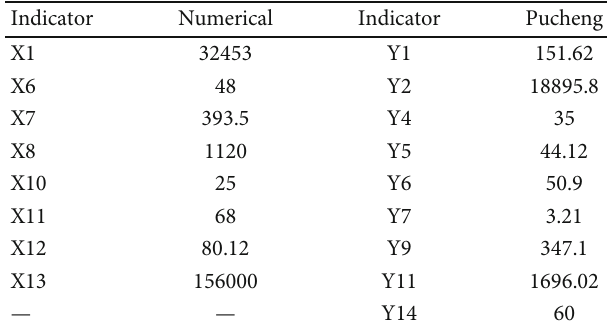
Table 3: Urban-rural spatial performance indicators of Pucheng County after dimension reduction